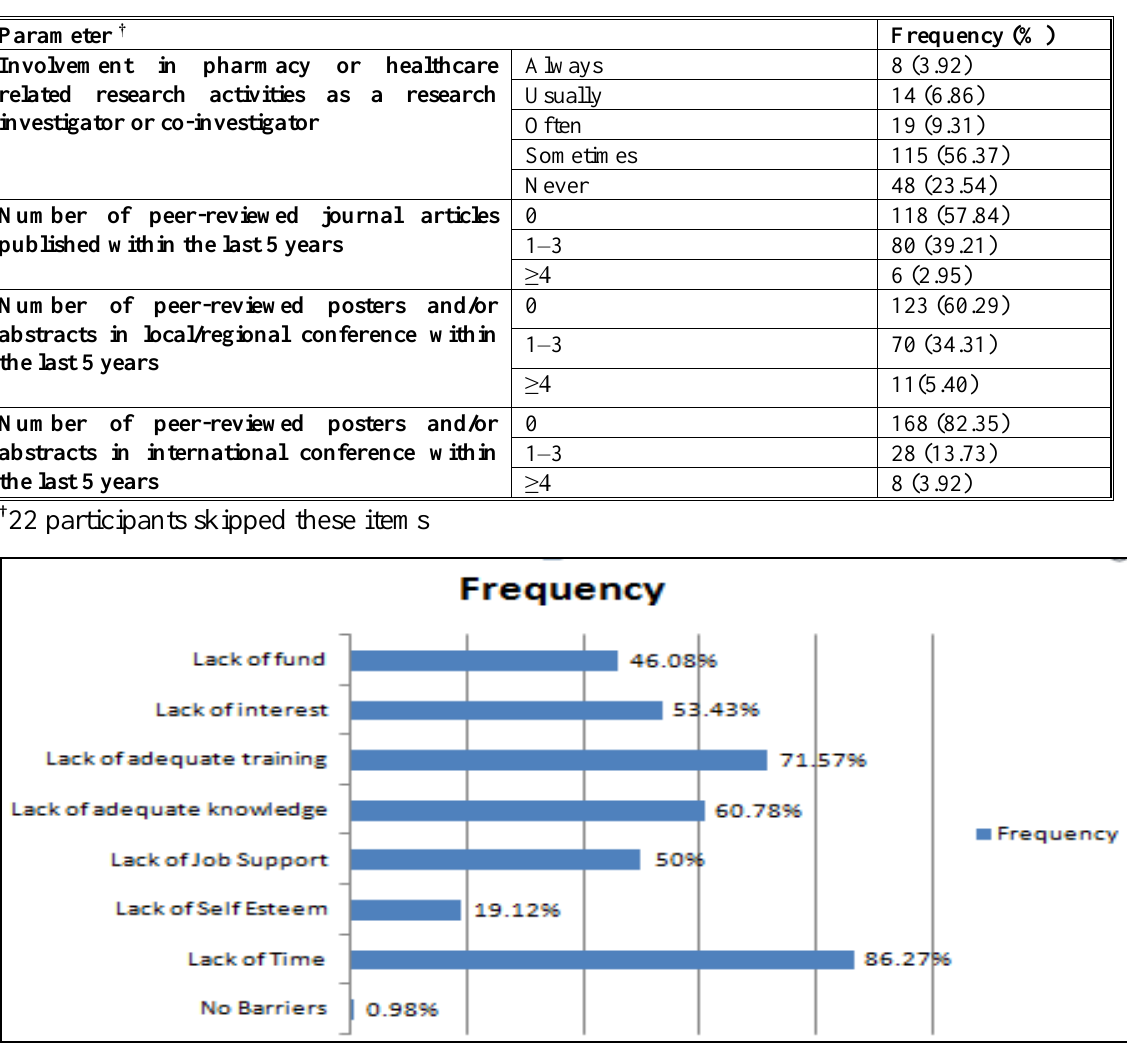
Figure 1. Pharmacists identified barriers to pharmacy practice-based research (n=